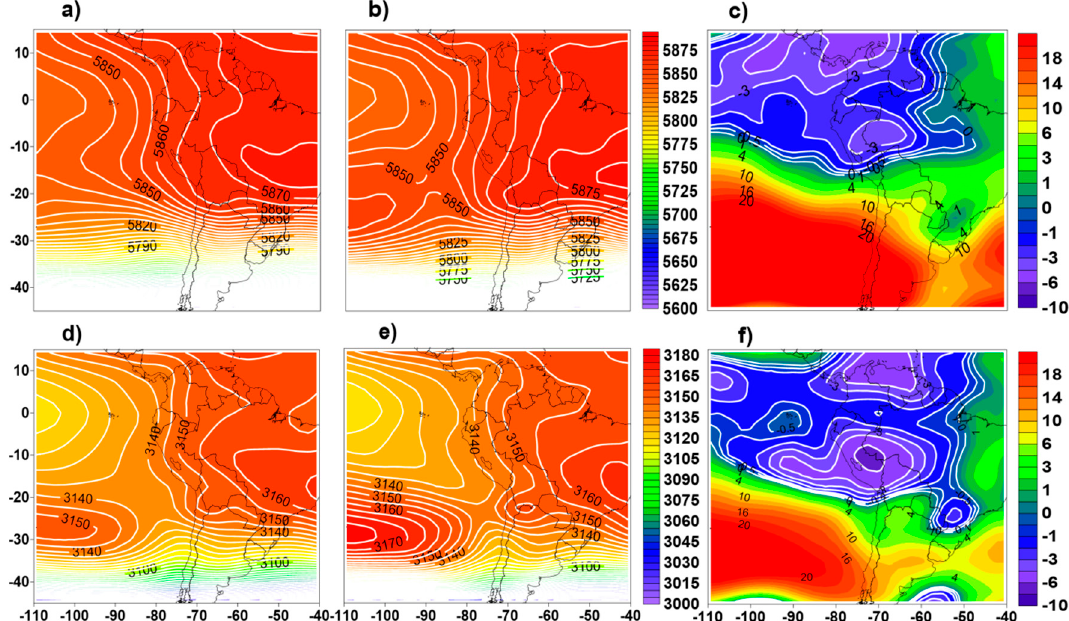
Figure 7. Geopotential height (m) composite charts for 500 hPa (top) and 700 hPa (bottom) averaged over the rainy seasons of 1981–2017 ( a , d ); the 40 extreme rainfall event cases ( b , e ) and their difference ( c , f ) to highlight deviations from the rainy season climatology.